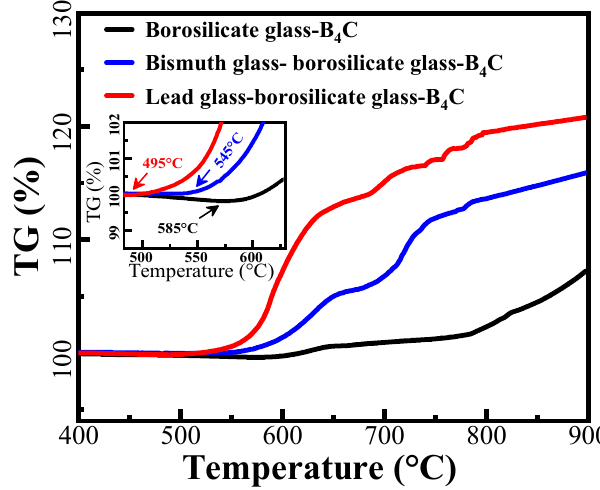
Figure 2. TG curves of different glass mixtures.